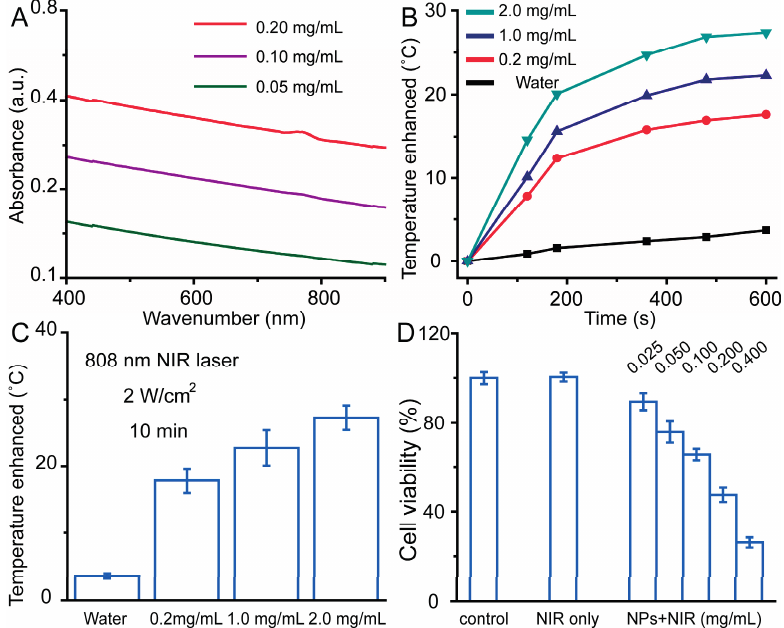
Figure 5. Room temperature UV–vis absorbance spectra of PEG–Fe 3 O 4 with different concentrations ( A ); Temperature elevation of PEG–Fe 3 O 4 as a function of time upon exposure to NIR light at 2 W·cm − 2 ( B ); Statistical analysis of above enhanced temperature based on three independent experiments ( C ); Photothermal effect of PEG–Fe 3 O 4 on viability of C6 cells with different experimental conditions ( D ).